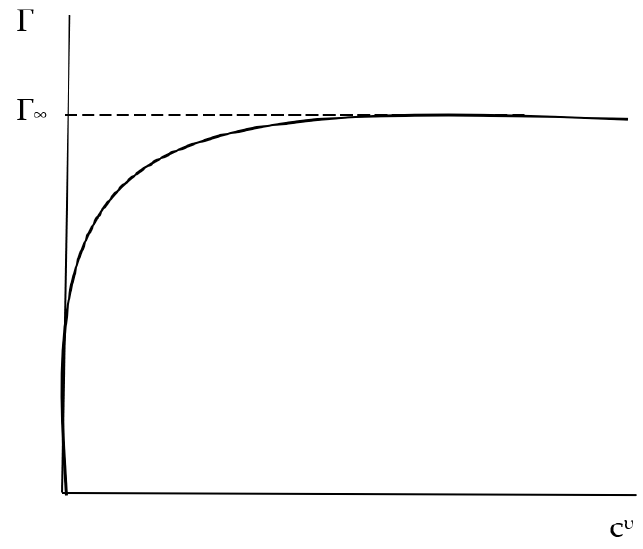
Figure 4. The dependence of Gibbs adsorption on the concentration of the plasticizer. Technical and physico-mechanical characteristics of both OPC and SPS-based sam- ples (20 × 20 × 20 mm and standard 40 × 40 × 160 mm) containing slag suspensions (10, 30, 50 g/L) stabilized with a sulfonaphthalene-formaldehyde-based plasticizer (5 g/L) were determined according to the national standard GOST 30744-2001 [55].